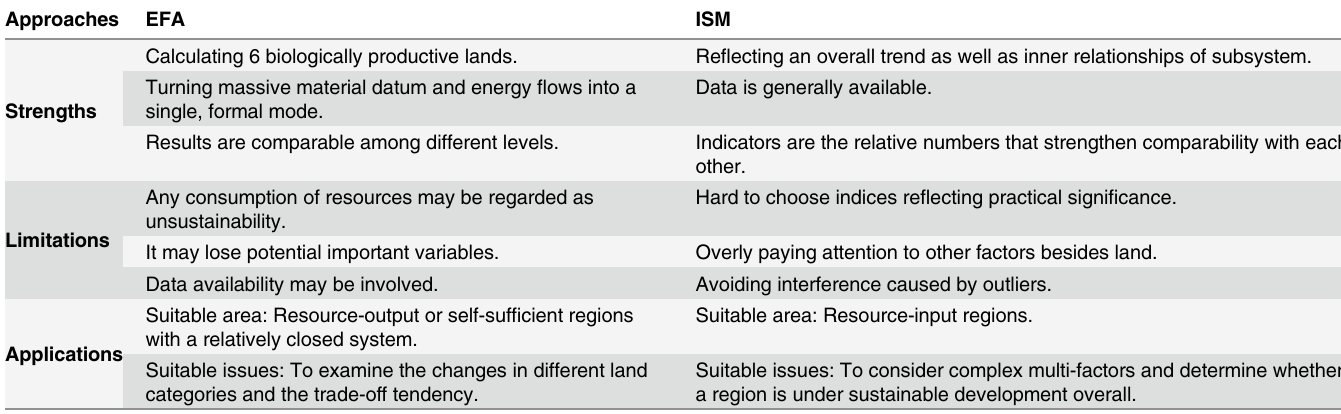
Table 6. Suitability of EFA and ISM for LCC assessment.